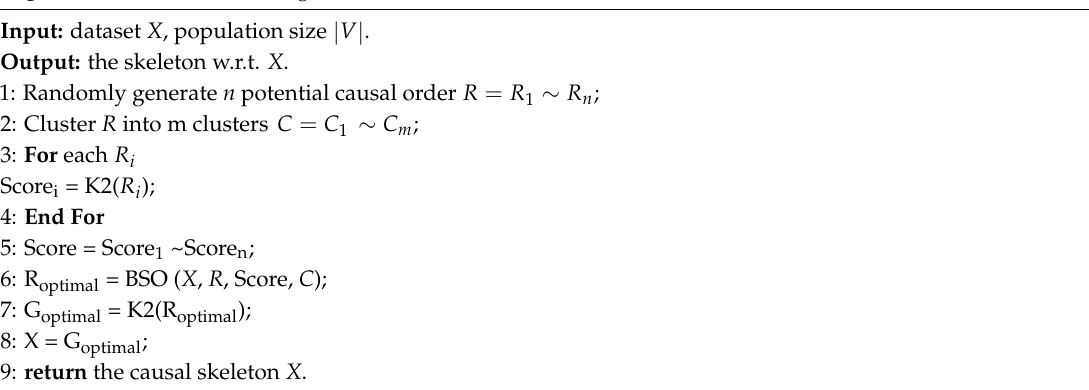
Algorithm 1. Skeleton learning based on K2-BSO.